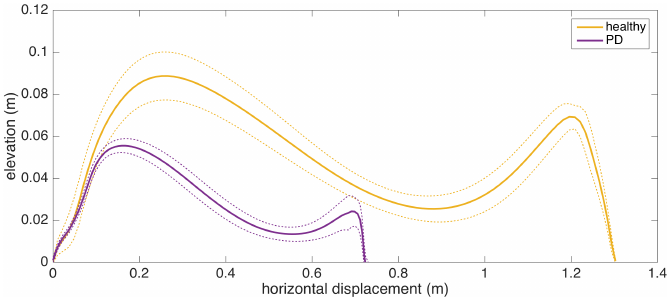
Figure 13. Comparison of average stride profiles of healthy and PD